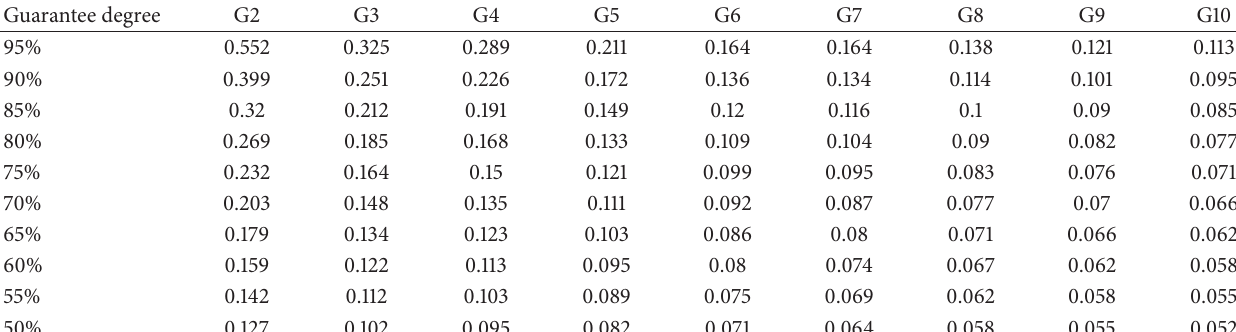
Table 3: Achievable error with different degrees of guarantee (populations composed of 100 individuals).